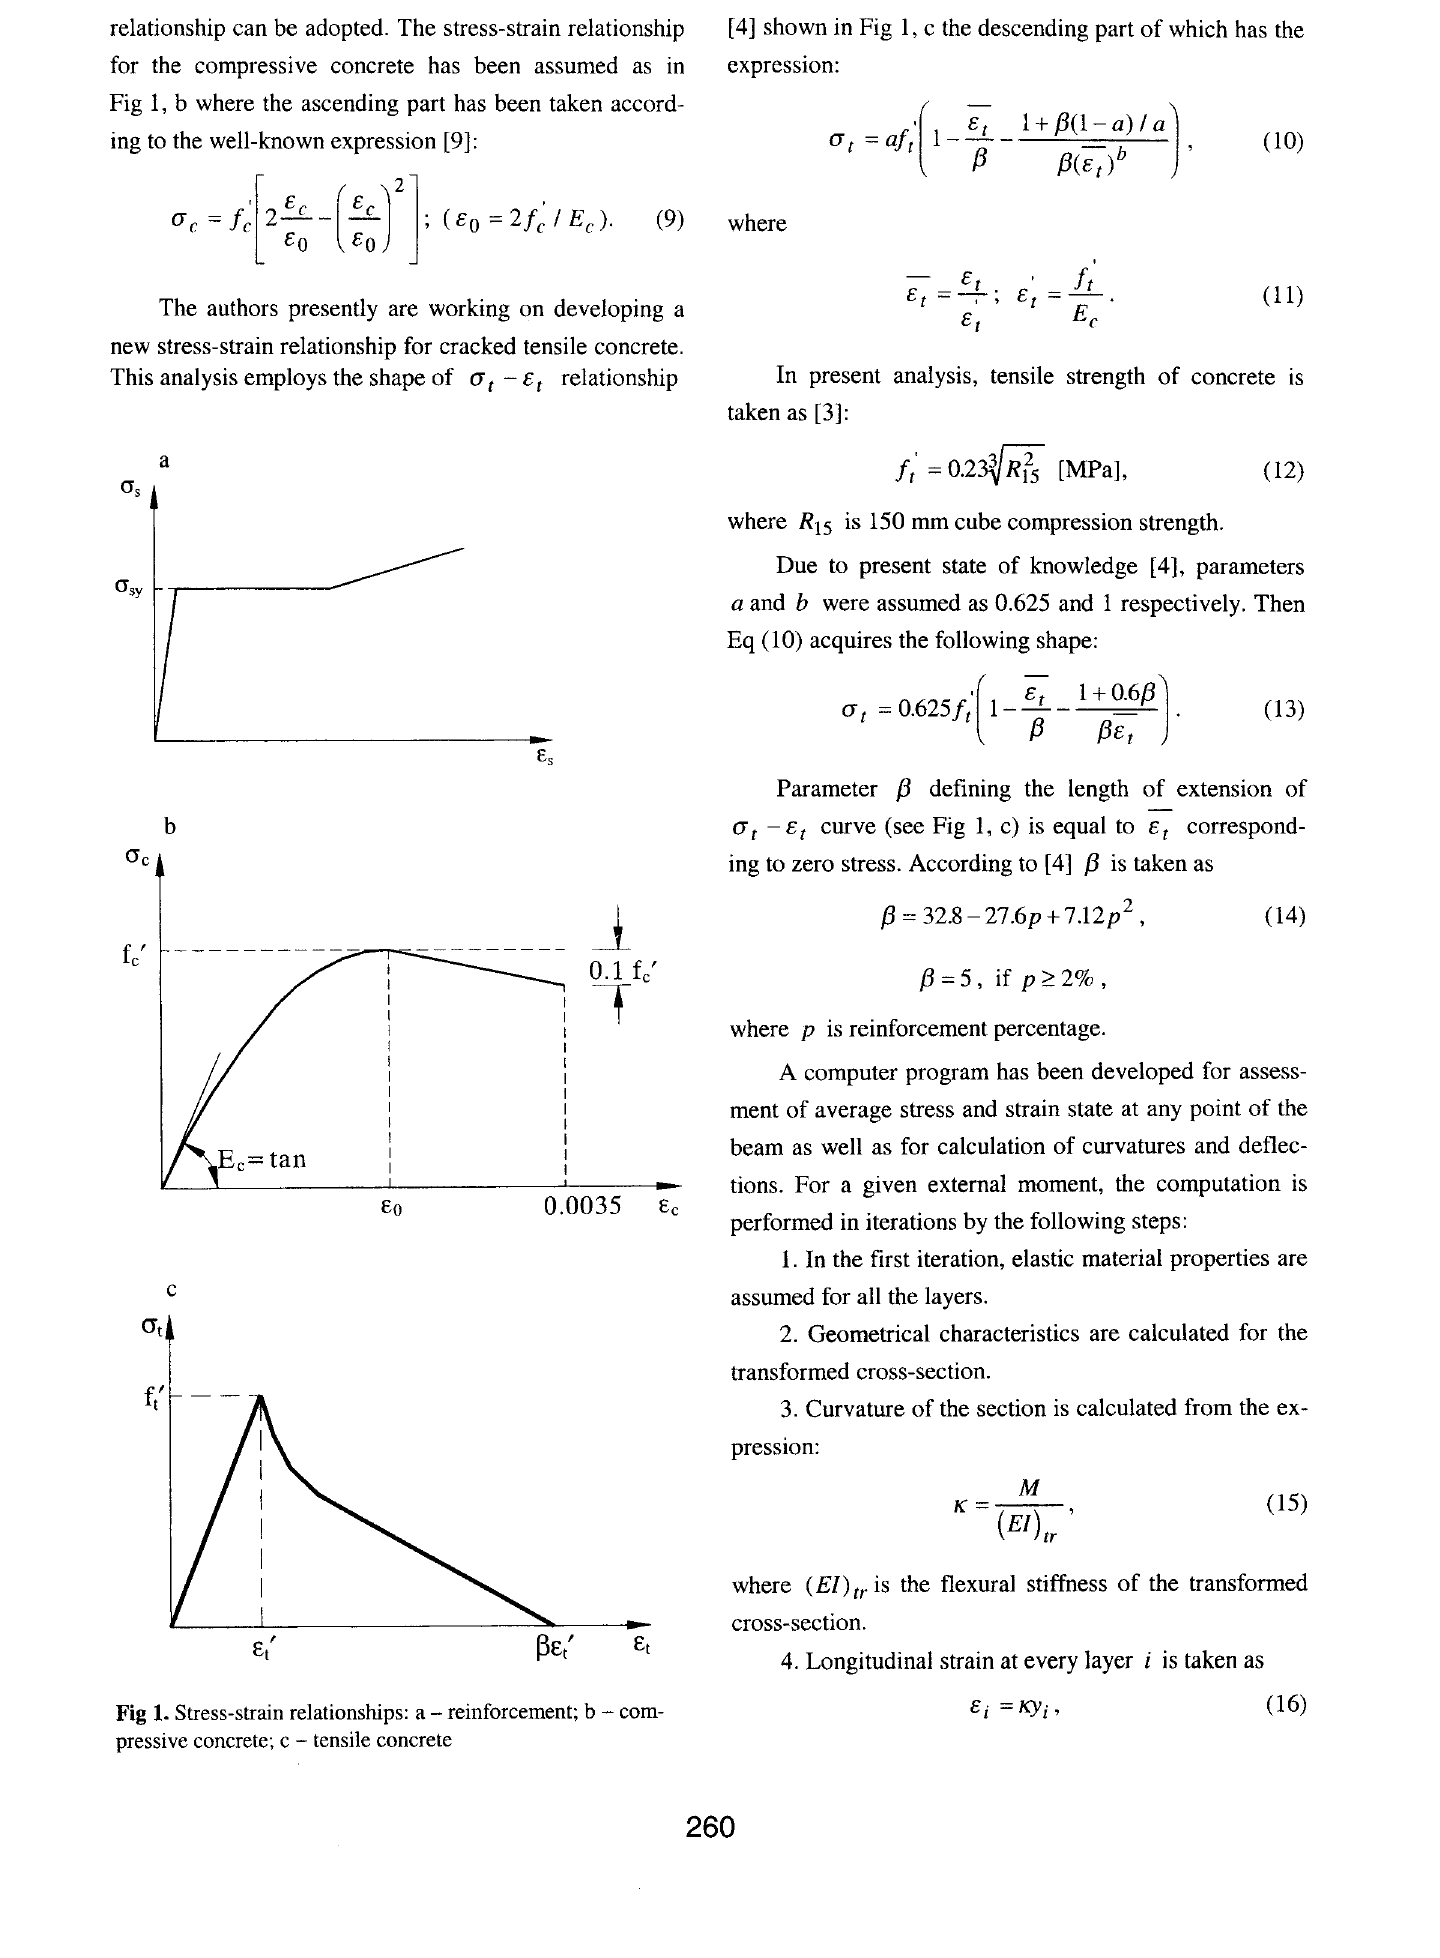
Fig 1. Stress-strain relationships: a- reinforcement; b - com pressive concrete; c - tensile